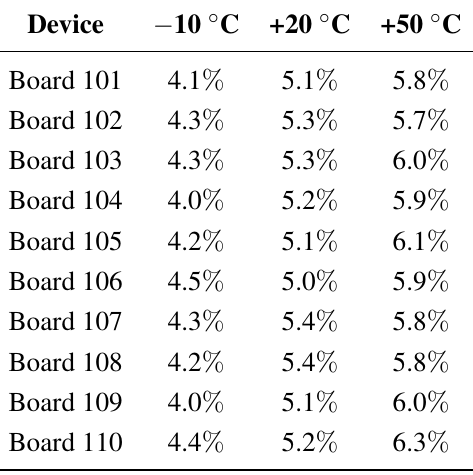
Table 1. Min-entropy results at different temperatures (Min-entropy denoted as the percentage of total available block